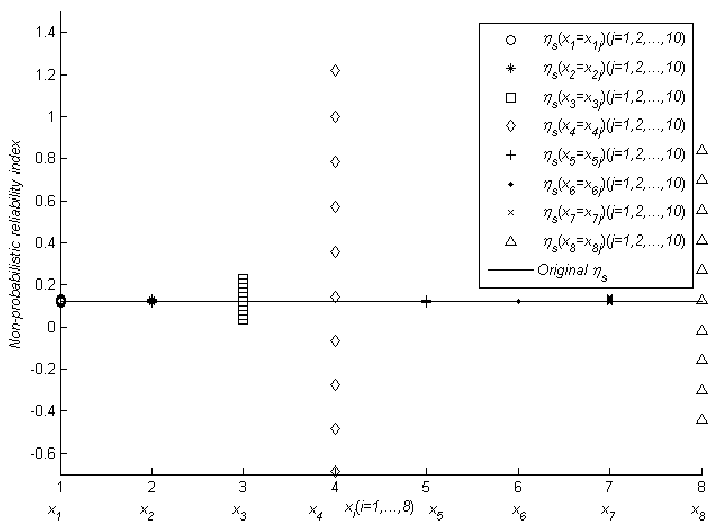
Figure 5. Point figure for conditional NPRI η s | x